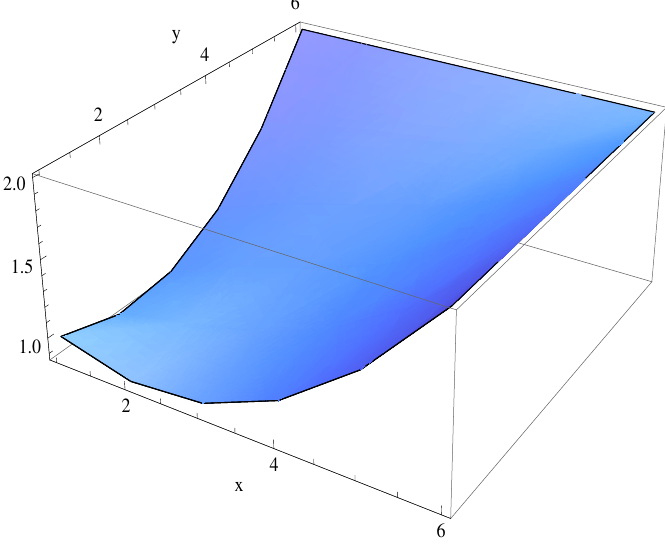
Figure 3. Approximated solution of Problems